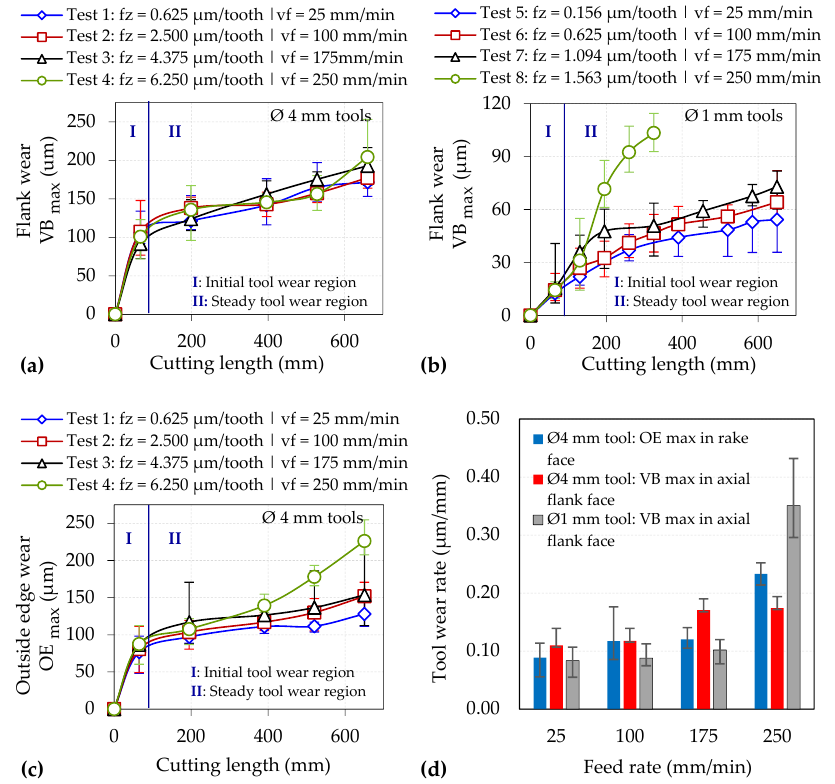
Figure 9. Flank wear curves for the ( a ) Ø 4 mm and ( b ) Ø 1 mm end-mills; ( c ) outside edge wear curves for Ø 4 mm end-mills; ( d ) tool wear rates obtained in the steady wear region (Lc > 90 mm).